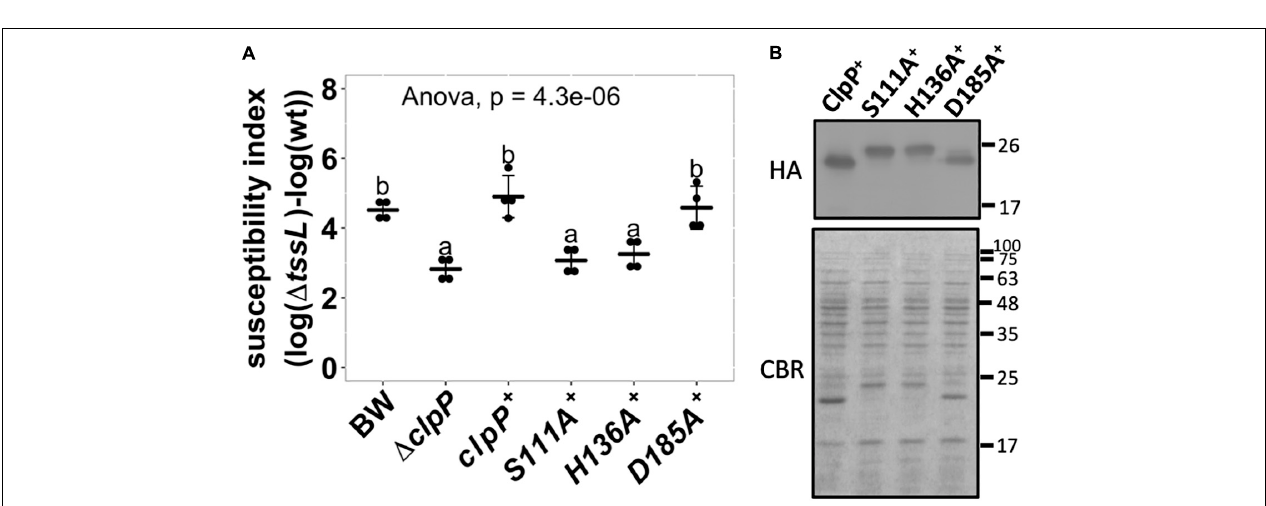
FIGURE 4 | Effects of ClpP protease catalytic variants in enhancing Agrobacterium tumefaciens type VI secretion system (T6SS) antibacterial activity. (A) The susceptibility index calculated from A. tumefaciens interbacterial activity assay against Escherichia coli . The A. tumefaciens C58 wild-type or (cid:49) tssL were co-cultured at a ratio of 10:1 with E. coli BW25113 wild type (BW), (cid:49) clpP , and (cid:49) clpP complemented with clpP and its variants expressed on plasmid. The complemented clpP strains were either wild type (clpP + ) or catalytic variants ClpP S111A (S111A + ), ClpP H136A (H136A + ), and ClpP D185A (D185A + ), with C-terminus HA-tag. The susceptibility index (SI) of each E. coli was calculated from the logarithm recovery rate of the (cid:49) tssL co-cultured group minus that of the wild-type co-cultured group. Data are mean ± SD of four biological replicates from two independent experiments. Statistical analysis involved single-factor analysis of variance (ANOVA) and Tukey honestly significant difference (HSD) with P < 0.05 for statistical significance. Two groups with significant differences are indicated with different letters (a and b). (B) The ClpP protein levels of the (cid:49) clpP complemented strains used in (A) . The ClpP-expressing E. coli strains were cultured at the same condition